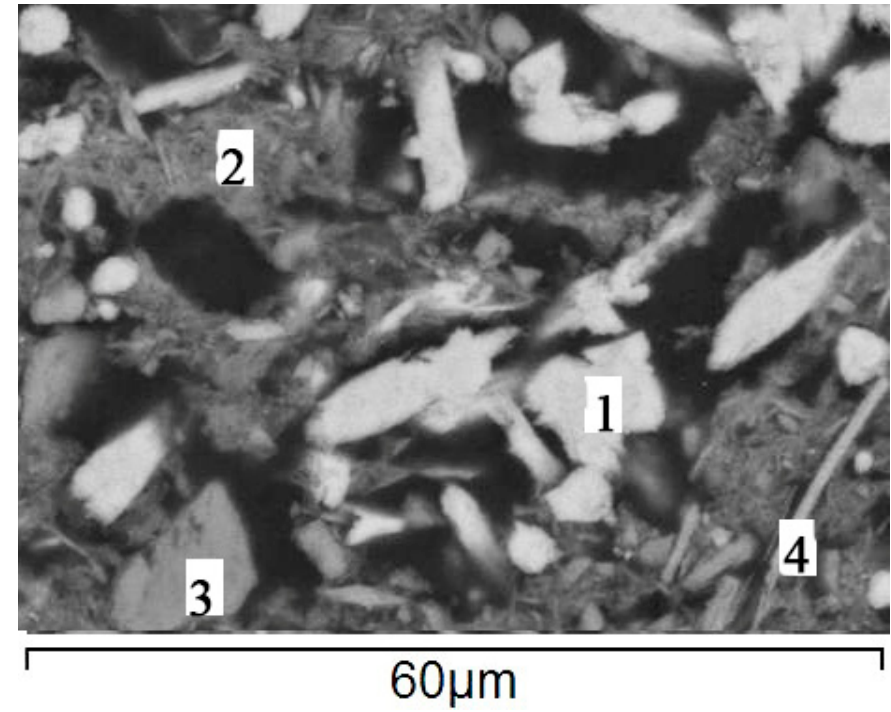
Figure 16. Electron micrograph of the minerals forming the bottom sediment layer in Lake Onego at a depth of 5–12 cm (ONG-4). 1—rhodochrosite; 2—thin-plate depositions of Fe-illite + Fe-chlorite + sections of diatoms, composed of opal; 3—feldspar debris; 4—biotite.